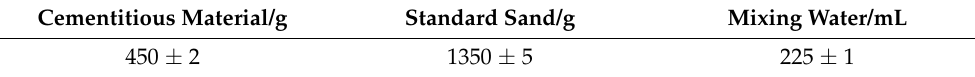
Table 1. Mixing ratio of mortar.